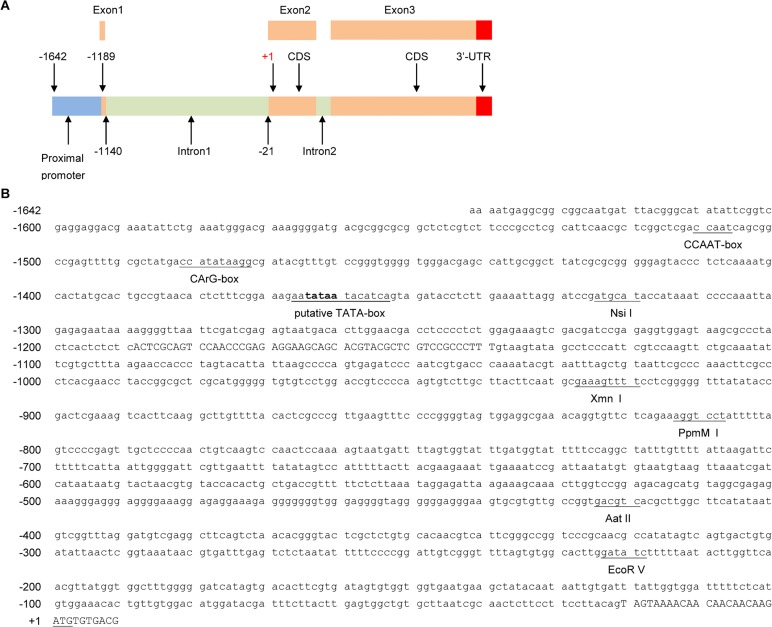
Nucleotide sequences of the fragment of a beta-actin gene isolated from the shrimp, Litopenaeus vannamei.A: A schematic map of the genomic sequence of L.v. beta-actin and the 5’-flanking sequences. The numbers indicate the positions (the first base of starting codon ATG was set as position+1). B: sequence of β-actin gene upstream region, untranslated exon1, intron1 and partial exon2. Sequences in exons are shown in uppercase letters, whereas those in introns and flanking regions are shown in lowercase letters. Numbering of the nucleotide sequences is given at the left. Underlined boldface letters shows CAAT, CArG and TATA boxes in the 5’-flanking region. The useful restriction enzyme sites are underlined with their name.